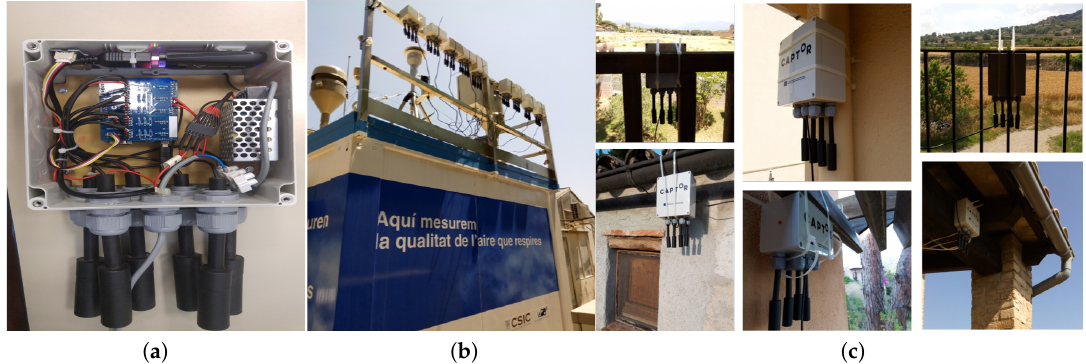
Figure 1. ( a ) Captor box, ( b ) Palau Reial reference station with captor nodes in calibration